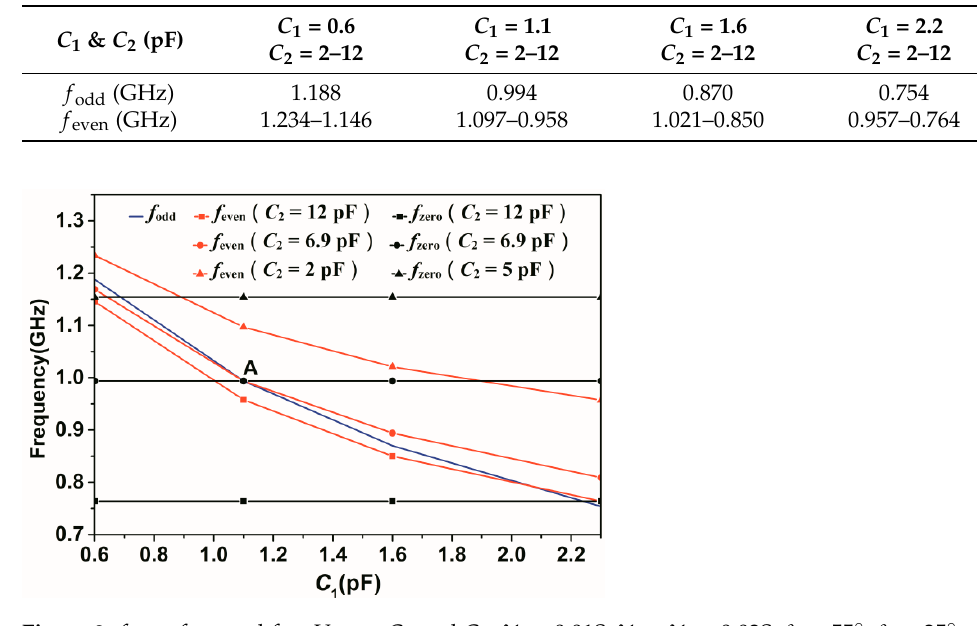
Figure 2. f even , f odd and f zero Versus C 1 and C 2 . Y 1 = 0.01S, Y 2 = Y 3 = 0.02S, θ 1 = 55°, θ 2 = 25° and θ 3 = 5° at 1 GHz.